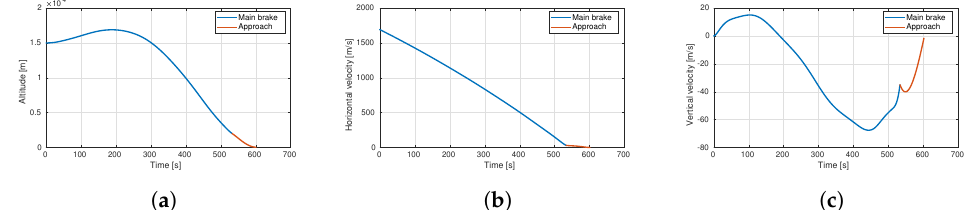
Figure 7. Altitude and velocity profile (horizontal and vertical) for the nominal landing trajectory (powered descent and final approach only). Same testing trajectory as [1]. ( a ) Altitude. ( b ) Horizontal velocity. ( c ) Vertical velocity.